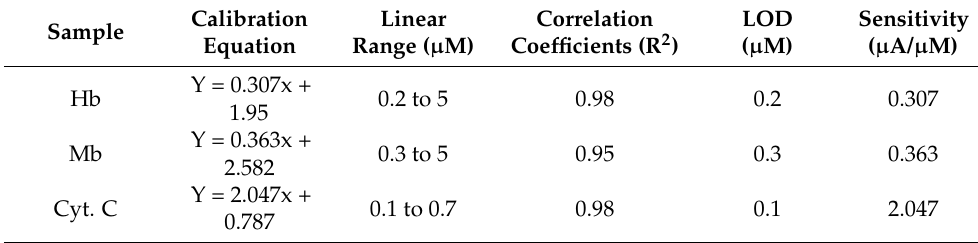
Table 1. The electrochemical performance of heme sensors .